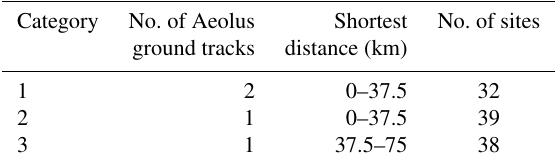
Table 1. Summary of the collocation categories used in this study: position of RWP sites relative to the nearest Aeolus ground tracks, calculated based on a 75km radius circle centered at each RWP